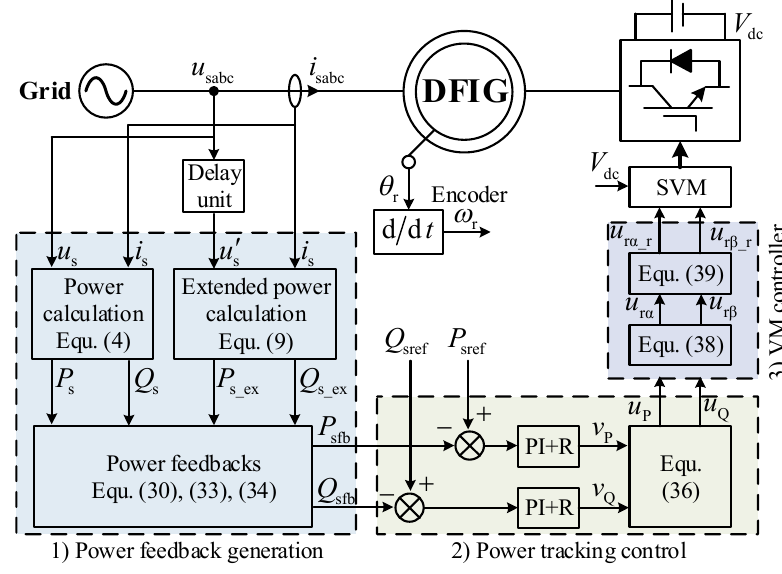
Figure 2. Block diagram of the developed voltage modulated direct power control (VM-DPC) strategy.